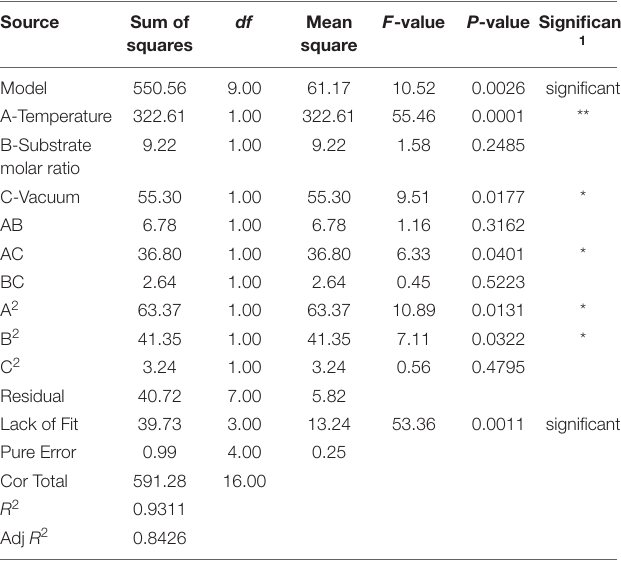
TABLE 2 | Regression coefficients and analysis of variance for response surface model fitting.